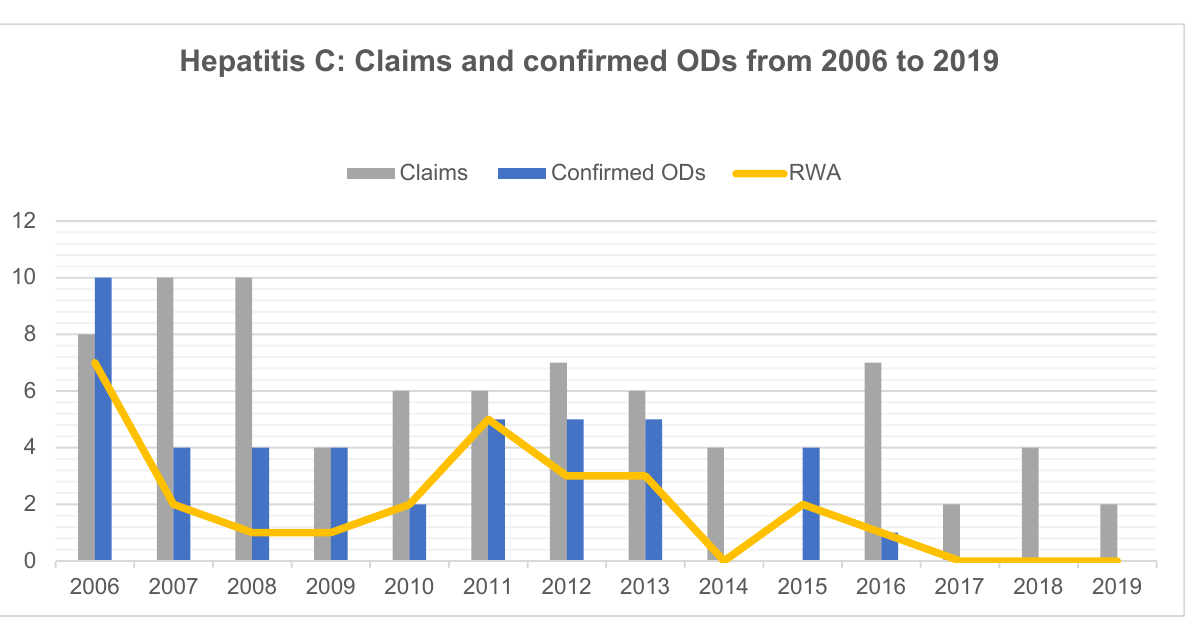
Figure 3. Hepatitis C virus infection: Number of claims, confirmed occupational diseases (ODs) and proportion of cases resulting in a reduced working ability (RWA) among dental health workers from 2006 to 2019.